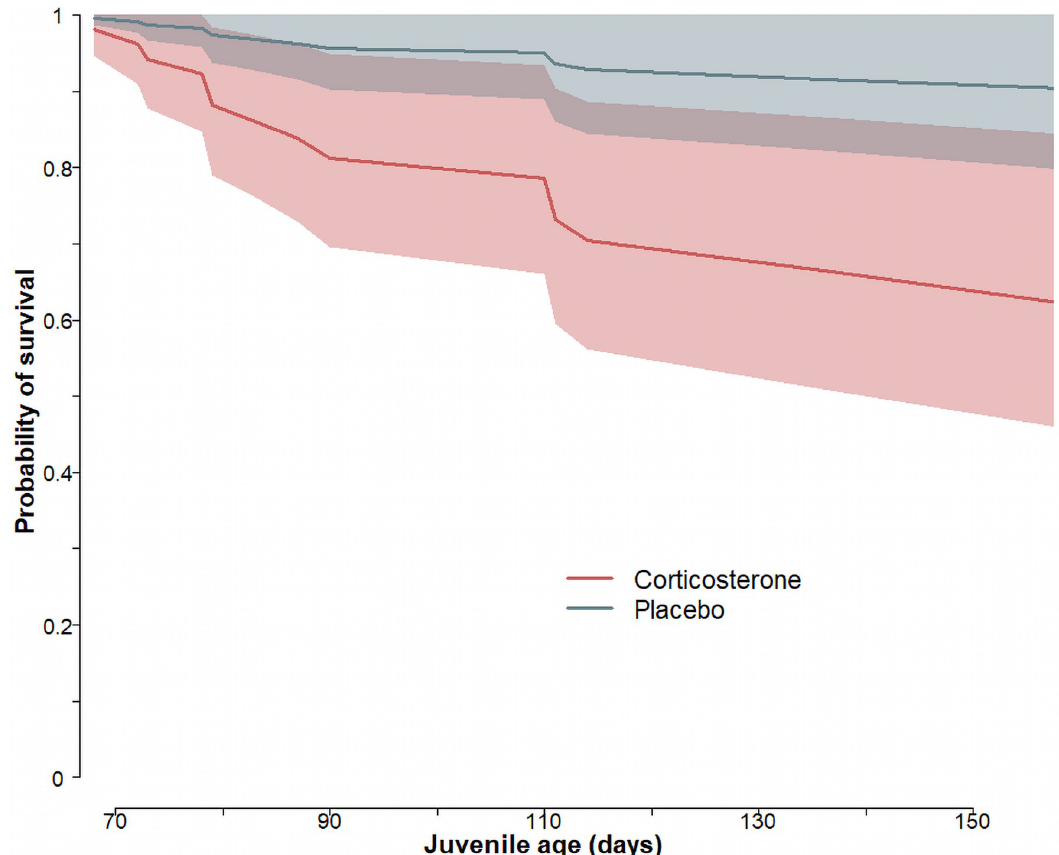
Fig 8. Probability of survival (with 95% CrI) in relation to age in corticosterone-implanted (red) and placebo-implanted (grey- green) juvenile barn